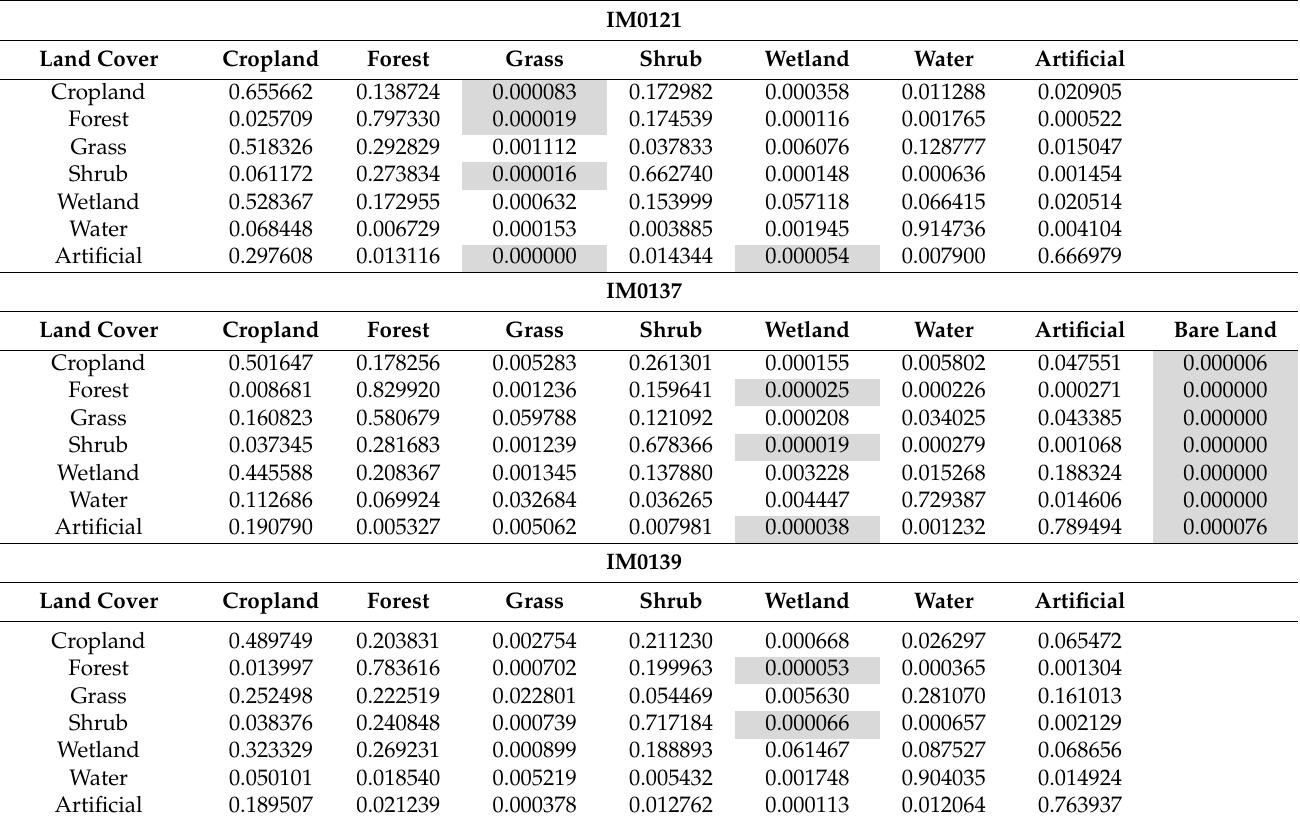
Table 6. Transformation probability matrix of land cover types in each eco-geographical zone based on GLC_FCS30 products